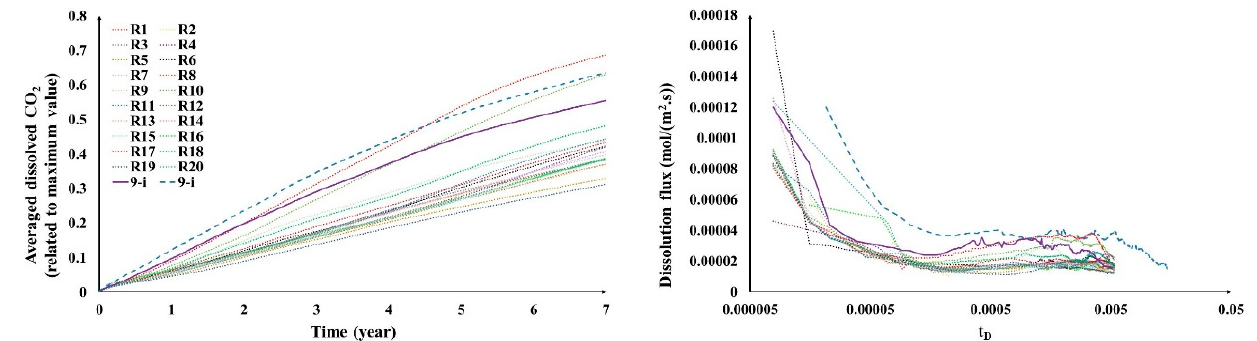
Fluids 2023 , 8 , x FOR PEER REVIEW 14 of 17